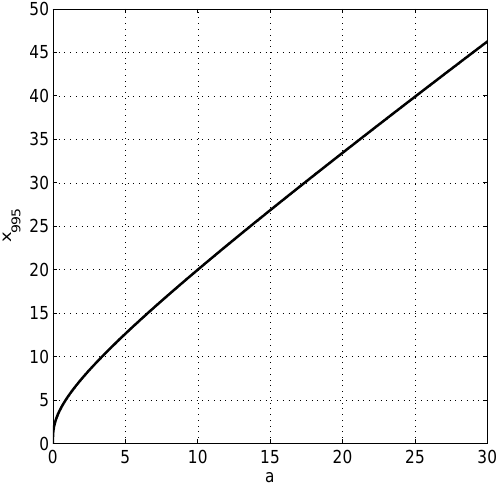
Fig. 2. x 995 as function of a . x 995 is defined by P(a,x 995 ) = 0 . 995.